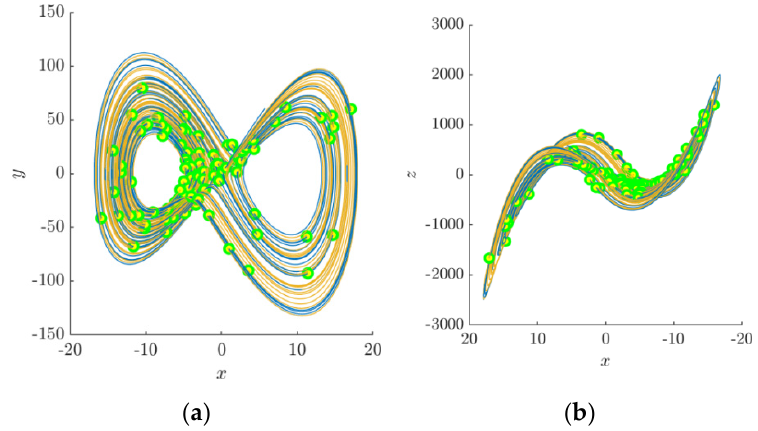
Figure 5. The trajectory of the modified Lorenz system Equation (37) is projected onto ( a ) x-y plane and ( b ) x-z plane. The green dots denote 95 data points, the blue line depicts the original trajectory, and the orange line depicts a trajectory of the reconstructed system.